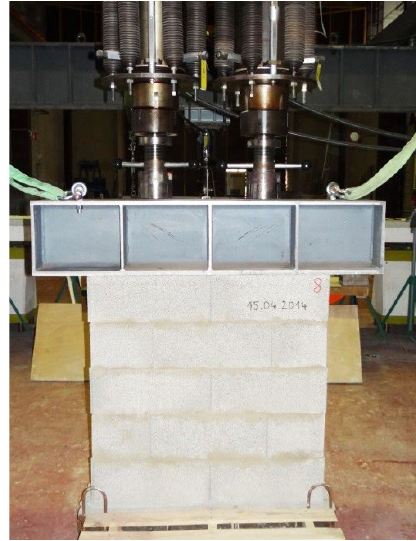
Fig. 5. Collar jointed wallettes ready